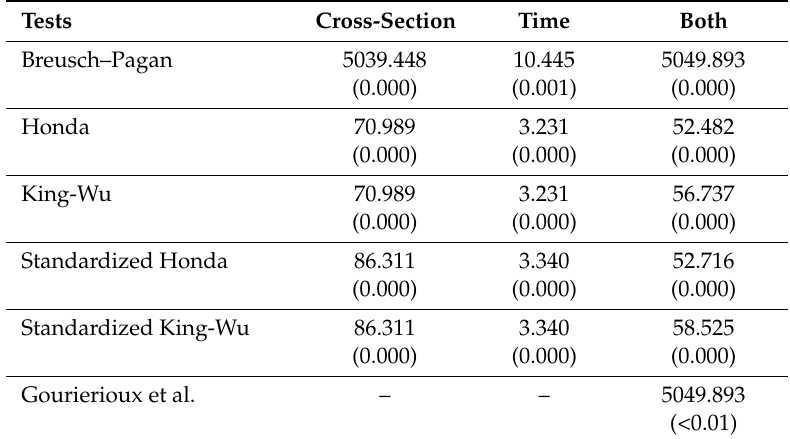
Table 4. LM test